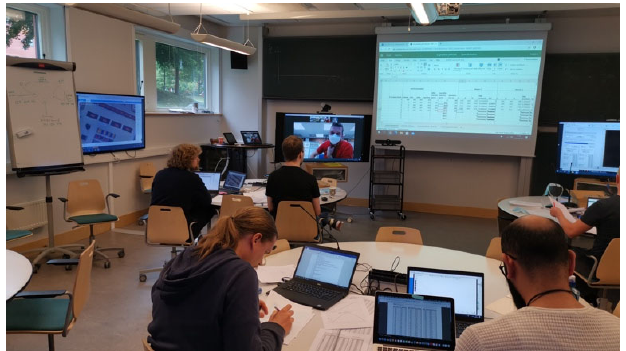
Figure 10 The students were using personal computers, larger monitors and a projector to both interact with the experiments and monitor the exercises